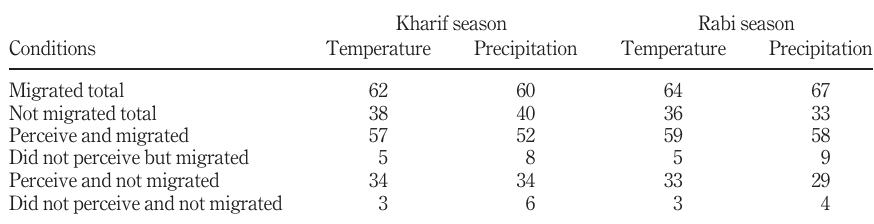
Table I. Perceptions of climate change/ variability as drivers of farmers ’ decisions to migrate